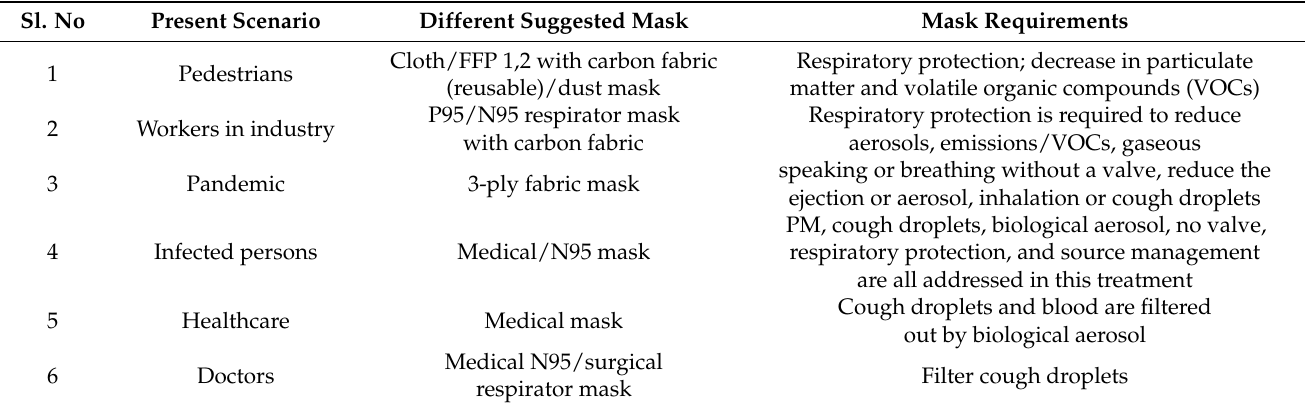
Table 7. Requirements of the suggested mask